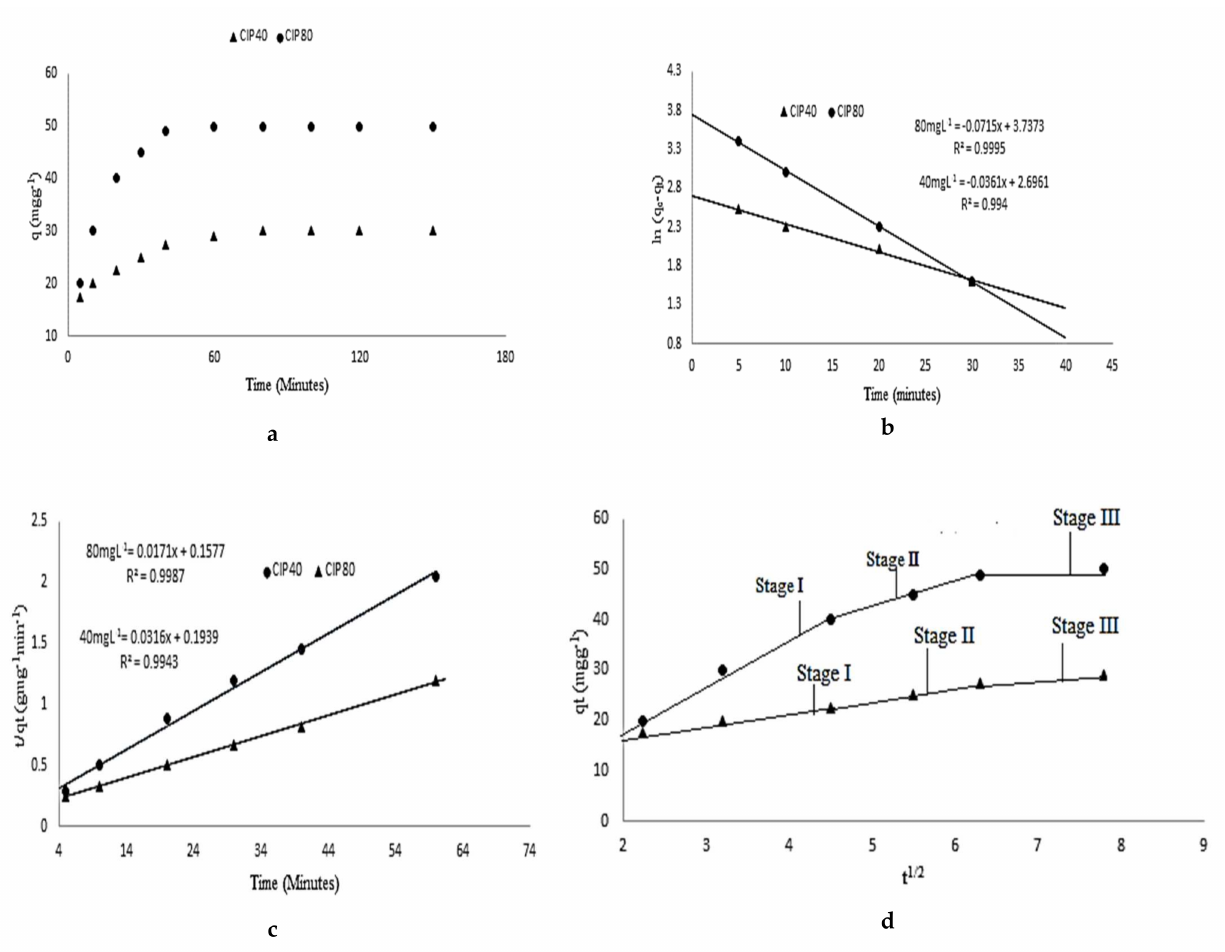
Figure 3. Adsorption kinetics plots of the CIPRO on the mango Fe 3 O 4 /C composite: ( a ) effect of contact time on adsorption ( b ) Pseudo 1st order kinetics plot ( c ) Pseudo 2nd order kinetics plot ( d ) Intra particle diffusion